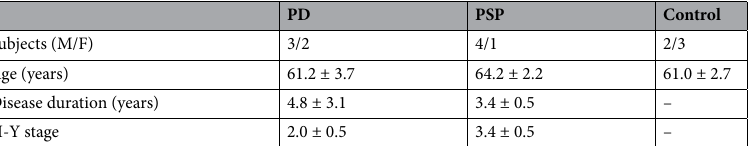
Table 2. Patients were clinically diagnosed by a movement disorder neurologist in accordance with the established criteria for each disorder 40,41 . Although there was no significant difference in age and disease duration between patients with PD and those with PSP, the H-Y stage was significantly higher in patients with PSP ( p = 0.008). All subjects provided informed consent and underwent 3 T in vivo MRI (Magnetom Skyra, Siemens, Erlangen, Germany) at Pusan National University Yangsan Hospital. SWI, R 2* map, and QSM were taken with a 2D gradi- ent echo sequence using the following parameters: TR = 2030 ms, TE = 3.1–29.9 ms (6 echoes with (cid:31) TE = 4.8, map was obtained using the same technique of postmortem MRI. QSM was reconstructed using MATLAB-